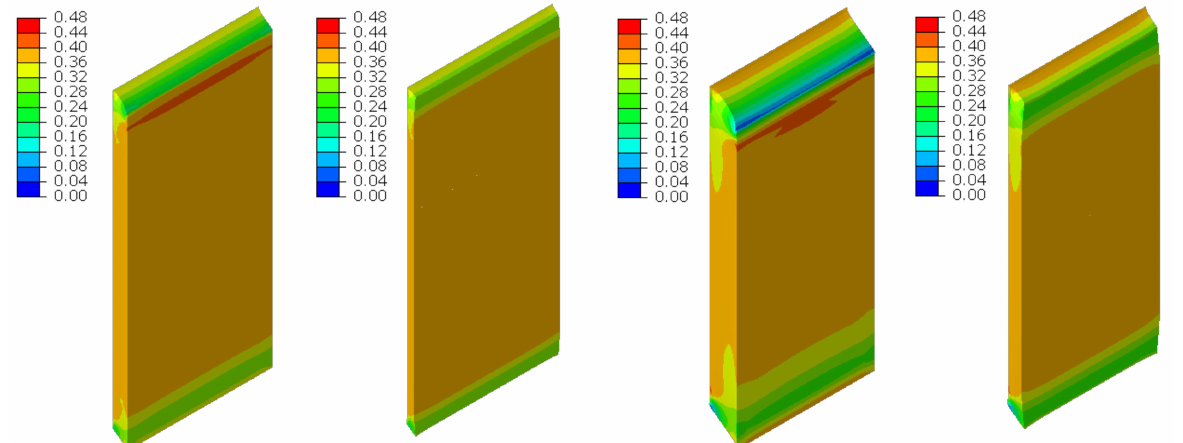
Figure 12. Deformations for scaling factor 1.0 and Cauchy stresses τ zy in MPa for total load level. The width of the gap is equal to 1.0 cm, left graphics, and 2.0 cm, right graphic. Views on connection, first and third columns, or central plane, second and fourth columns.